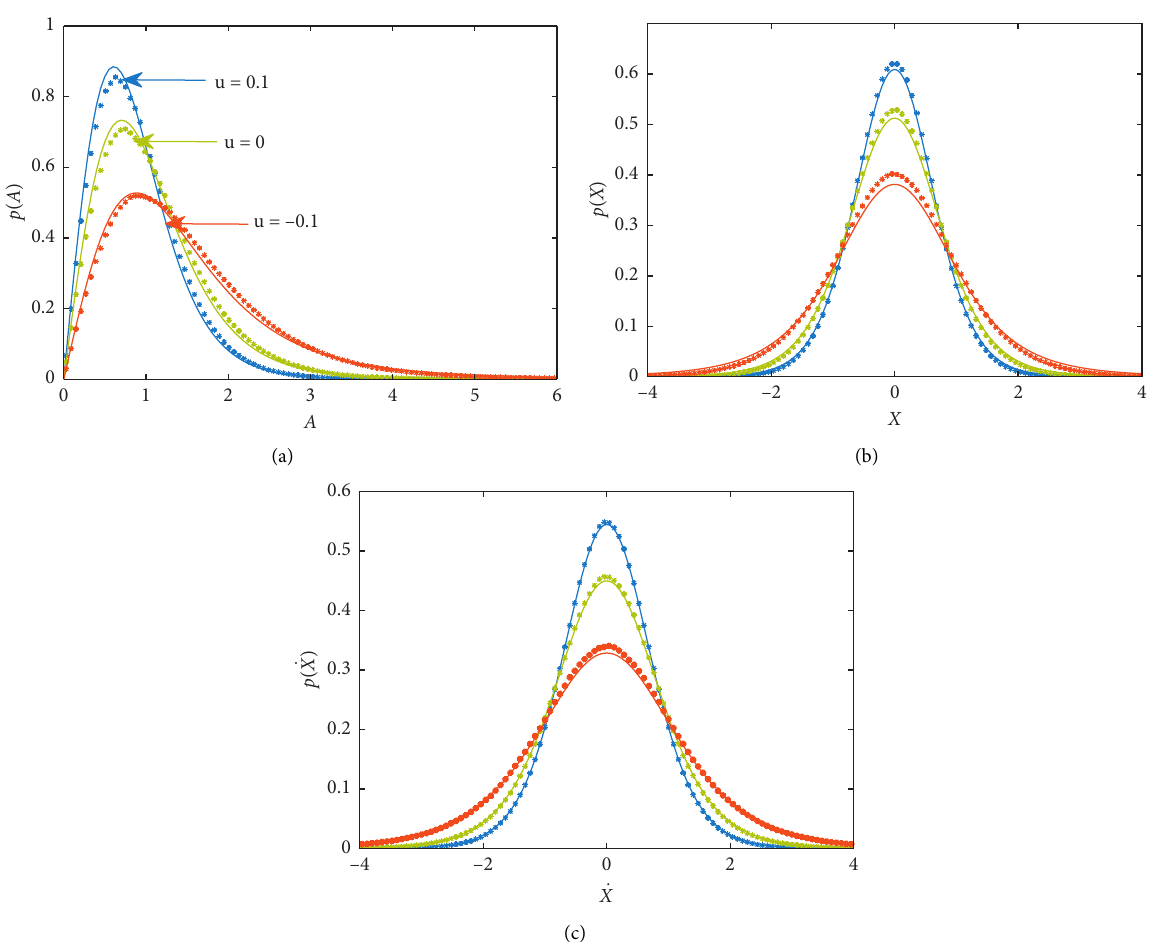
Figure 3: The stationary PDFs under feedback strength. (a) Amplitude, (b) displacement, and (c) velocity. Theoretical analysis results (-) and Monte Carlo simulation results ( ∗ ).